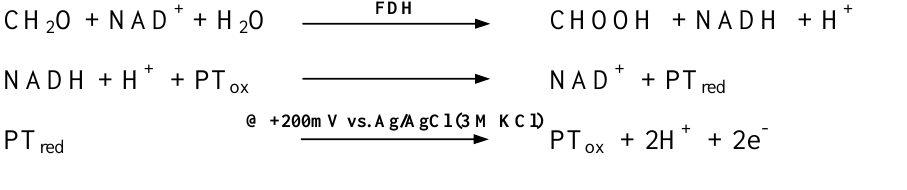
Figure. 1. Reaction steps for monitoring formaldehyde using the enzyme formaldehyde dehydrogenase (FDH), and phenothiazine (PT) as electrochemical